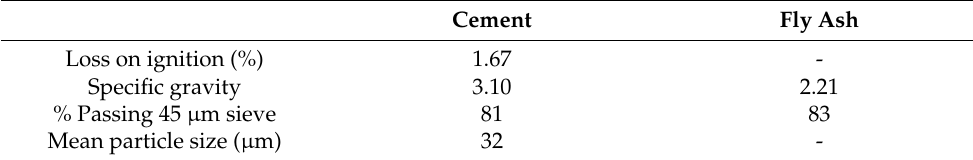
Table 2. Physical properties of cement and fly ash.